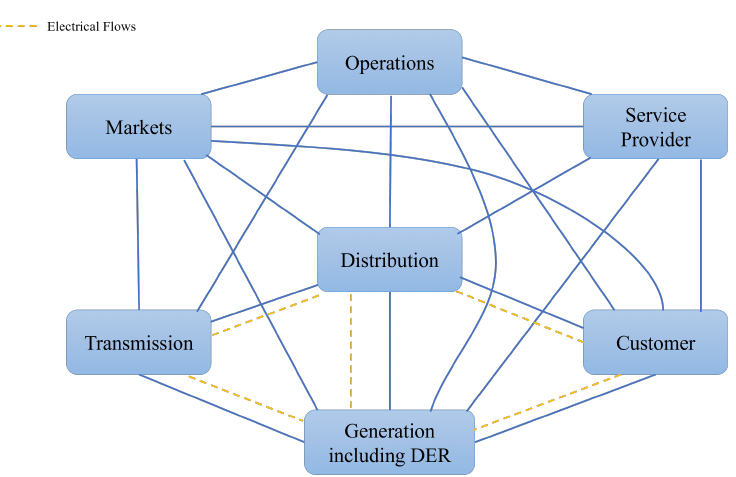
Figure 1. NIST smart grid conceptual network